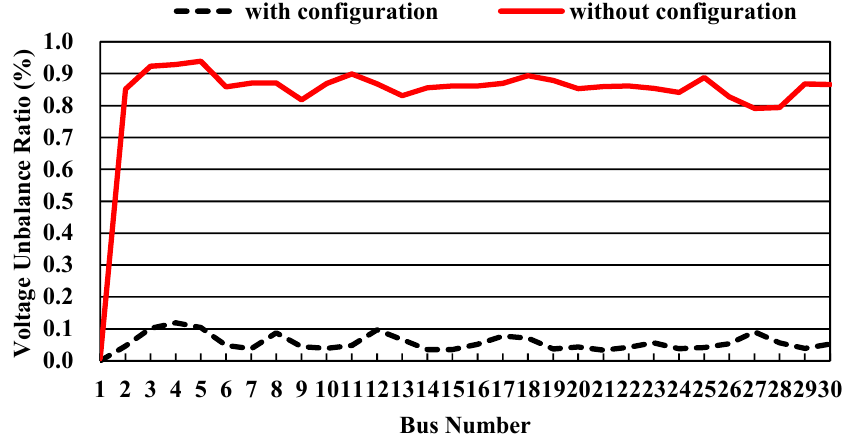
Figure 13. Comparison of the improvement in the voltage imbalance ratio for the INER 30 ‐ Bus system.